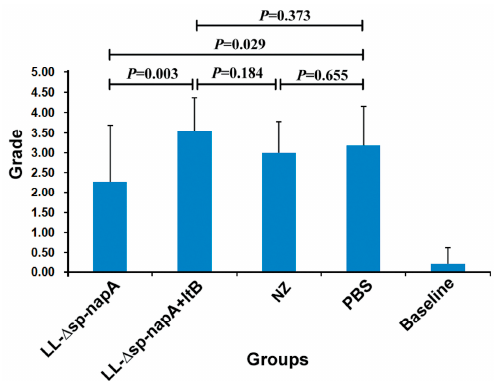
Figure 8. Comparison of the groups on severity of gastric inflammatory changes. Gastric inflammatory changes of the mice were graded using the reported method [25,31]. Data were expressed as mean ± SEM. Error bars indicate standard deviations. NZ- ∆ sp-napA , NZ- ∆ sp-napA + ltB , NZ and PBS groups ( n = 11 each) were gavages with NZ3900 / pNZ- ∆ sp- napA , mixture of NZ3900 / pNZ- ∆ sp- napA and NZ3900 / pNZ-sp- ltB , NZ3900 / pNZ8110 and PBS, respectively, and challenged with H. pylori . No gavages were performed on Baseline group ( n = 10). Fisher’s LSD test, compared with the PBS or designated group.